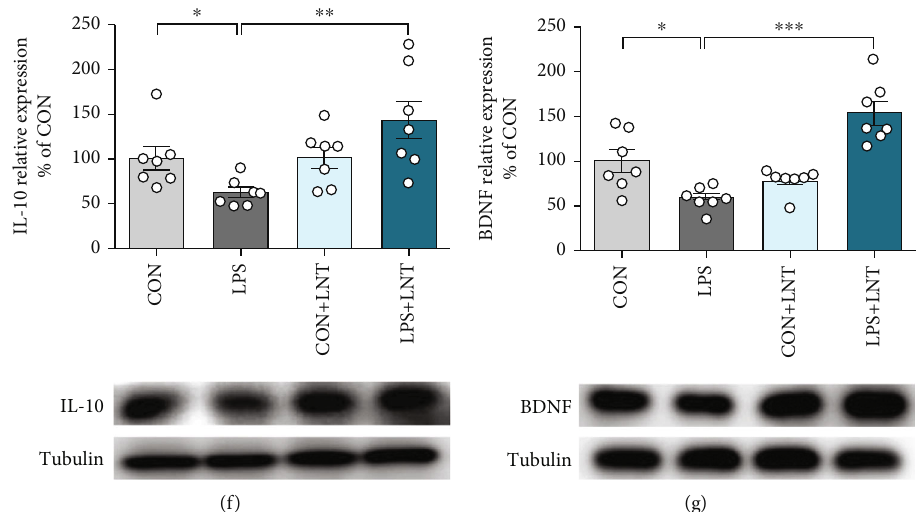
Figure 2: LNT inhibited LPS-induced microglial cell in fl ammation in BV2 cells. (a) Representative images showing the expression of iNOS and Arg-1 in the experimental groups. The protein levels of iNOS (b), Arg-1 (c), TNF- α (d), IL-1 β (e), IL-10 (f), and BDNF (g) were detected by Western blot. White arrows indicate representative cells in the treatment group. All data are presented as the mean ± SEM . Scale bar = 50 μ m (a). Statistical analysis was performed using one-way ANOVA followed by the post hoc Tukey tests. ( ∗ P < 0 : 05 , ∗∗ P < 0 : 01 , and ∗∗∗ P < 0 : 001